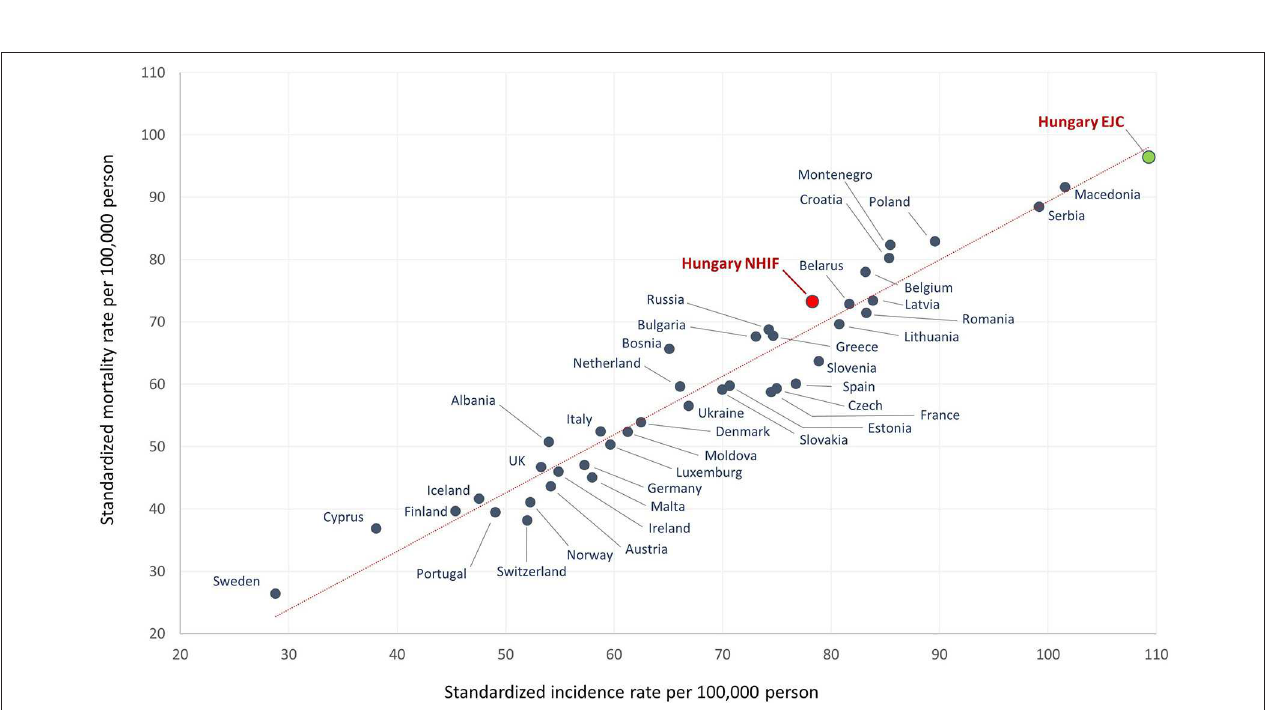
FIGURE 3 | Age-standardized incidence and mortality rates per 100,000 person-years among male lung cancer patients in European countries and Hungary based on the NHIF survey in 2012 (using ESP 1976). Description: A dot in the graph shows age-standardized incidence and mortality rates together for a country. The Y axis represents the standardized mortality rate per 100,000 population, while the X axis represents the standardized incidence rate per 100,000 population.